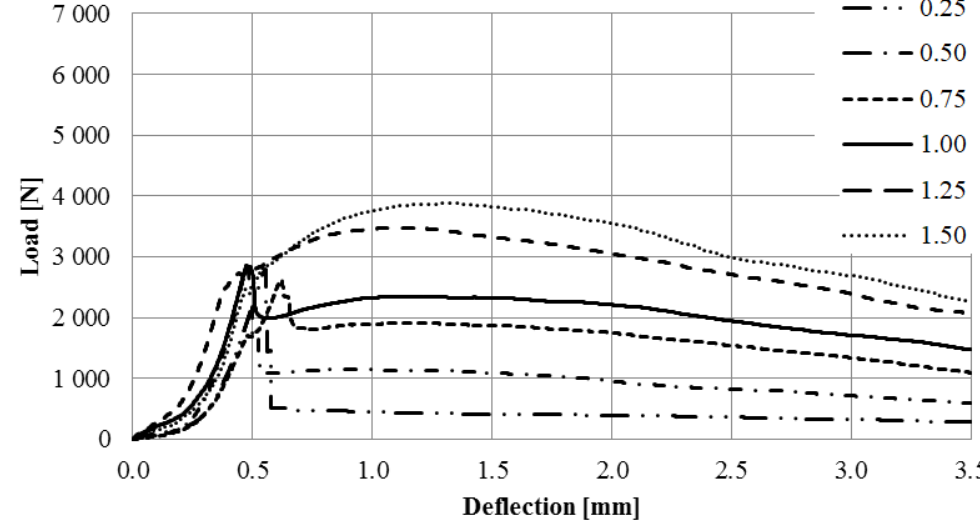
Figure 11. Load-deflection curve for specimens with steel microfibers. Figure 12 presents curve for specimens with steel microfibers.